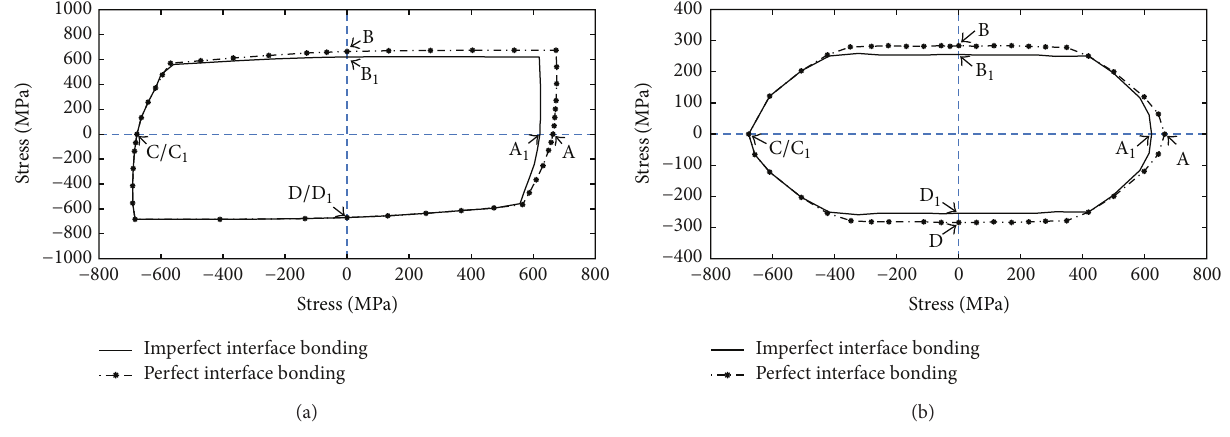
Figure 4: The failure envelopes of [0//90]